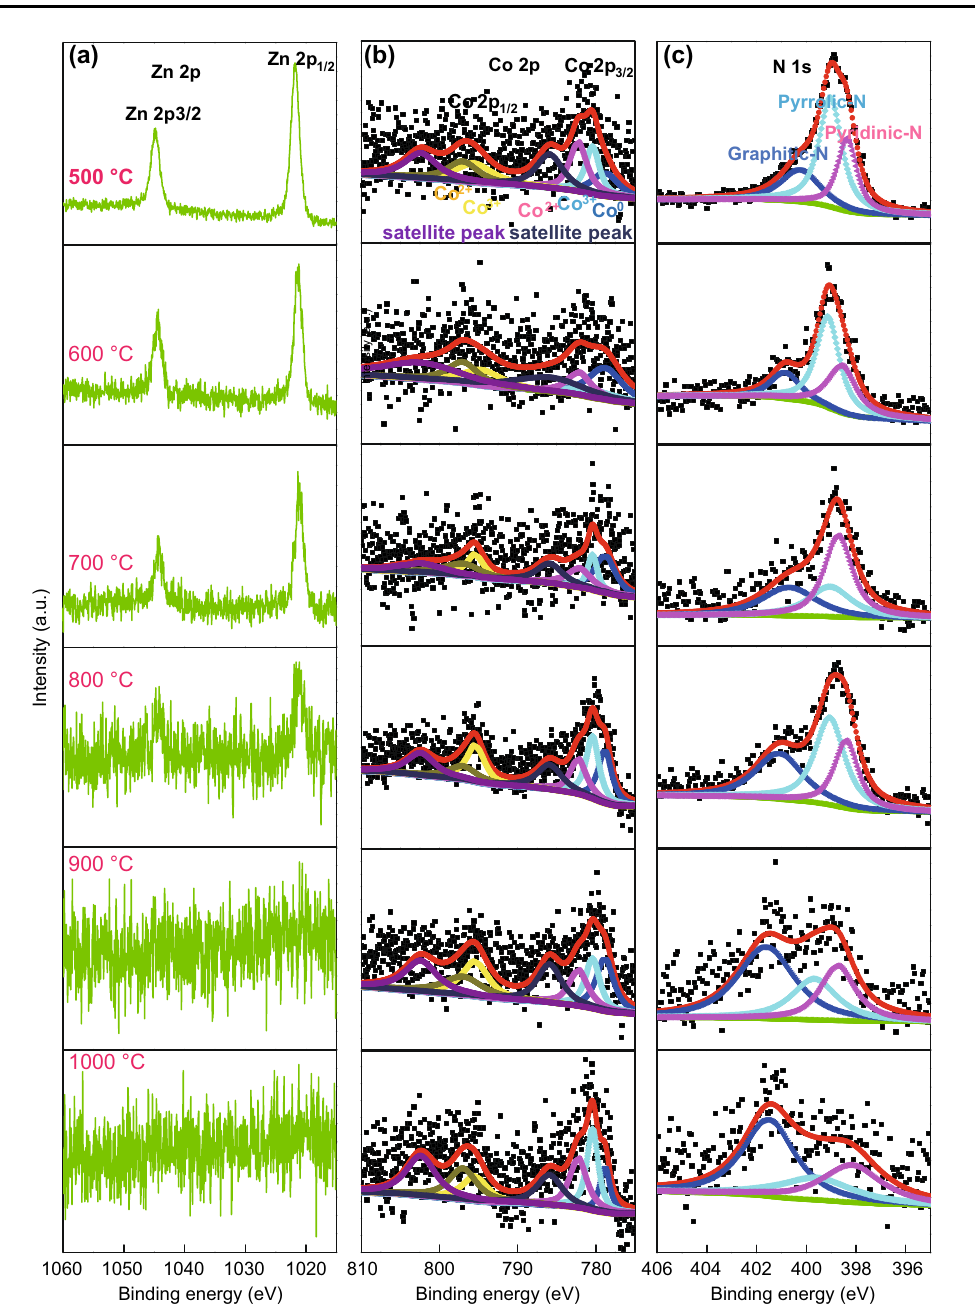
Fig. 6 XPS high-resolution spectra of a Zn 2 p , b Co 2 p , and c N 1 s levels at different carbonization